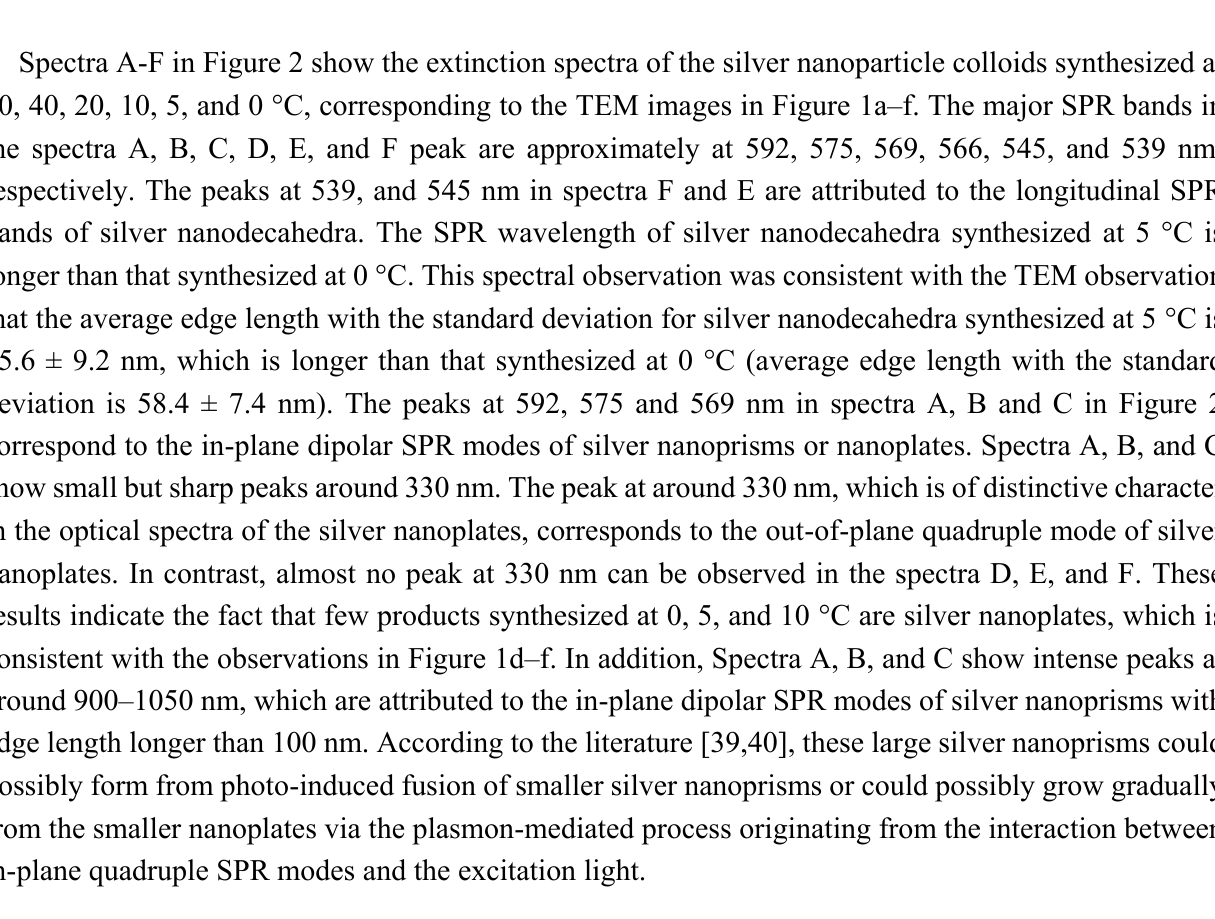
Figure 2. Extinction spectra of silver colloids synthesized at ( A ) 60 °C; ( B ) 40